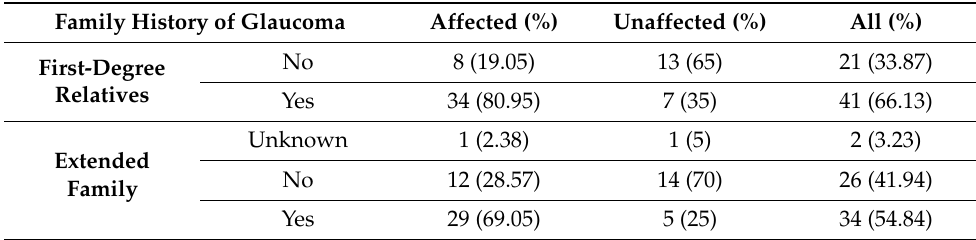
Table 2. Family history of glaucoma in GGLEAM study participants. First-degree relatives include parents and siblings. Extended family includes aunts, uncles, and cousins. Family History of Glaucoma Affected